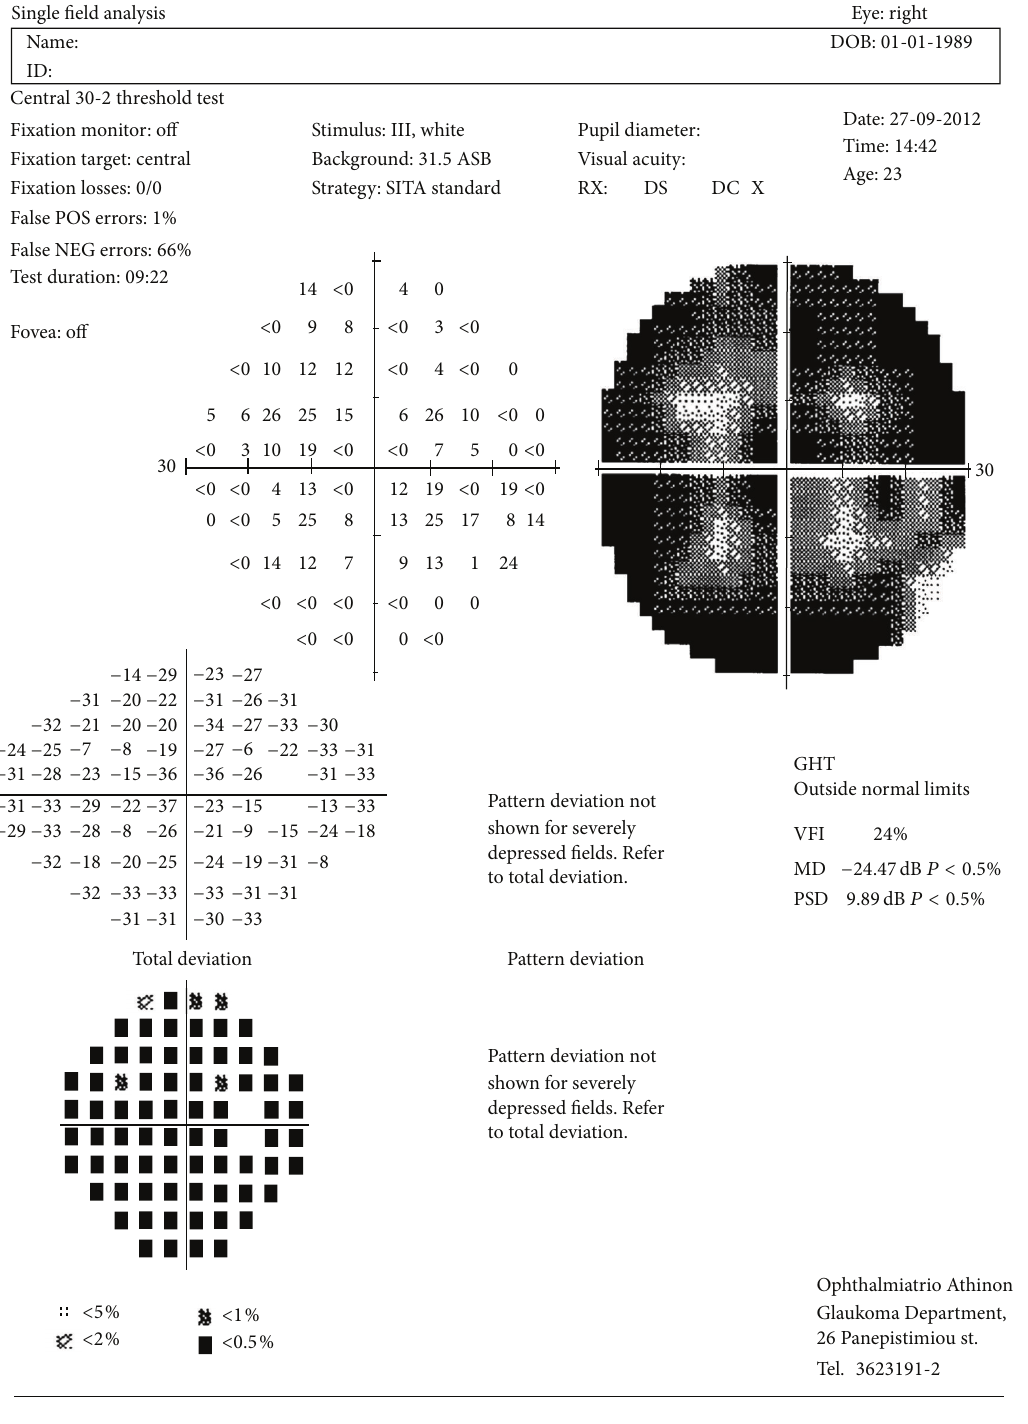
Pattern deviation not shown for severely depressed fields. Refer to total deviation.